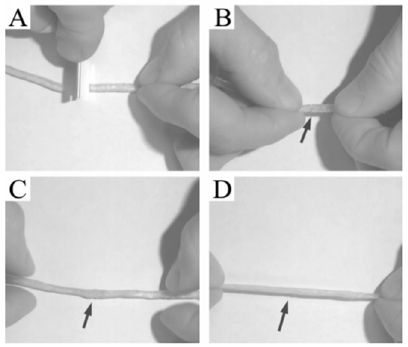
Figure 8. The self-healing testing of supramolecular elastomer ( A ): Cut; ( B ): Join; ( C ): Mend; ( D ): Stretch.